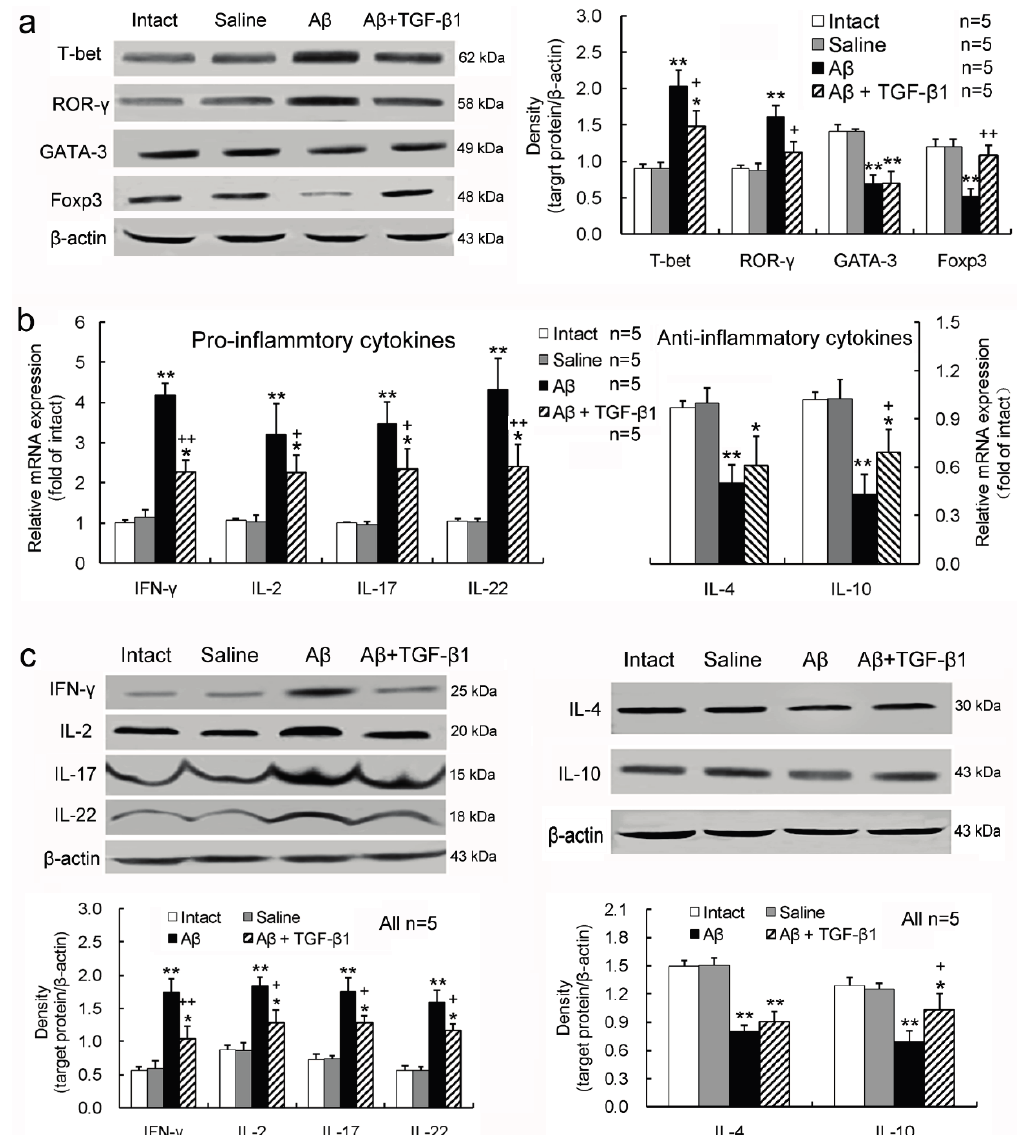
Figure 3. TGF- β 1 alleviates pro-inflammatory enhancement and anti-inflammatory attenuation of T-lymphocytes induced by A β 1–42 in the hippocampus. ( a ) Expression levels of transcription factors T-bet, ROR- γ , GATA-3 and Foxp3 specific for Th1, Th17, Th2 and Treg cells, respectively; ( b ) Gene expression levels of pro-inflammatory and anti-inflammatory cytokines in the hippocampus; ( c ) Protein expression levels of the pro-inflammatory and anti-inflammatory cytokines in the hippocampus. * p < 0.05, ** p < 0.01, versus intact or saline treatment; + p < 0.05, ++ p < 0.01, versus A β 1–42 injection